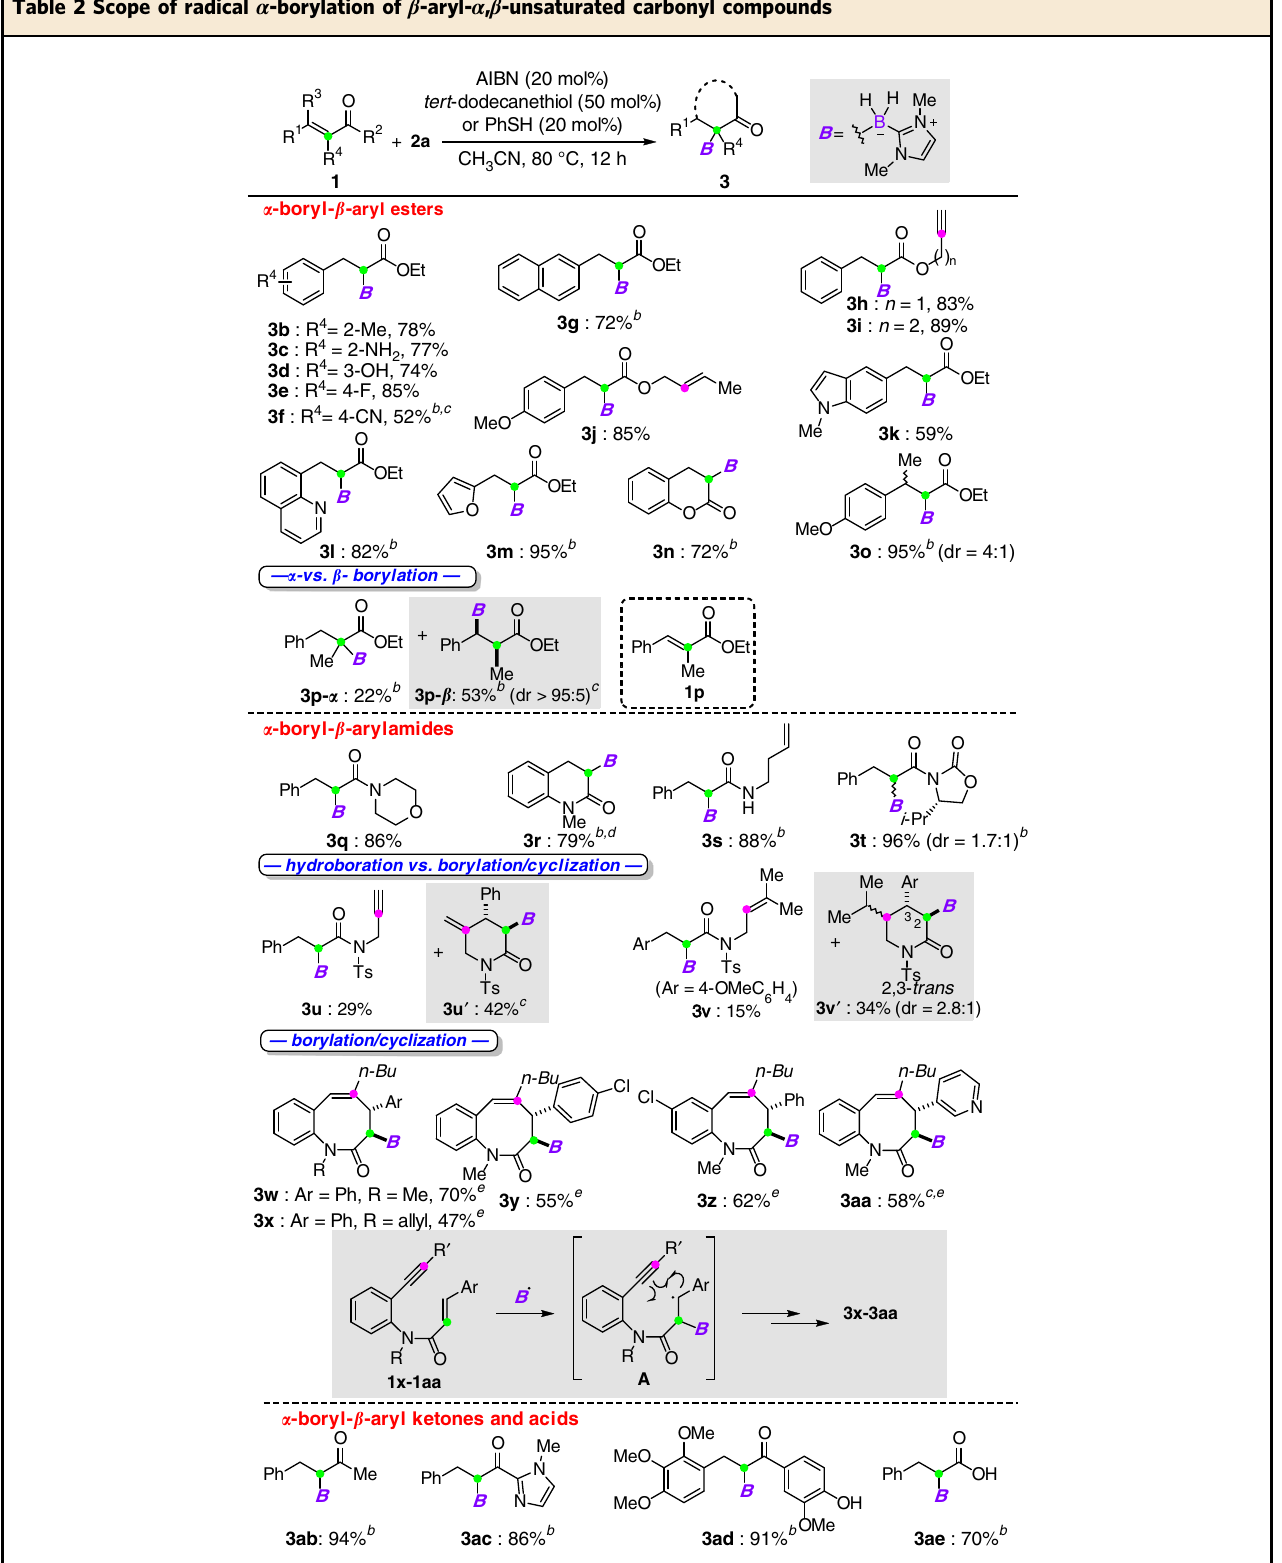
Table 2 Scope of radical α -borylation of β -aryl- α , β -unsaturated carbonyl